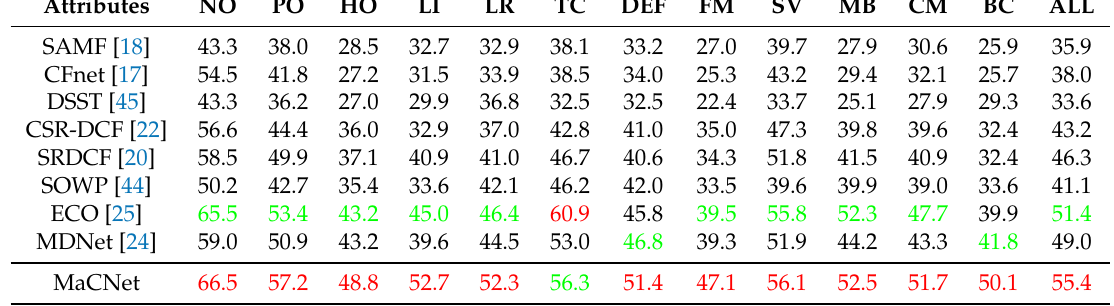
Table 6. Attribute-based SR scores (%) on RGBT234 dataset [13] against with eight RGB trackers. Optimal and suboptimal results are represented by red and green fonts, respectively.